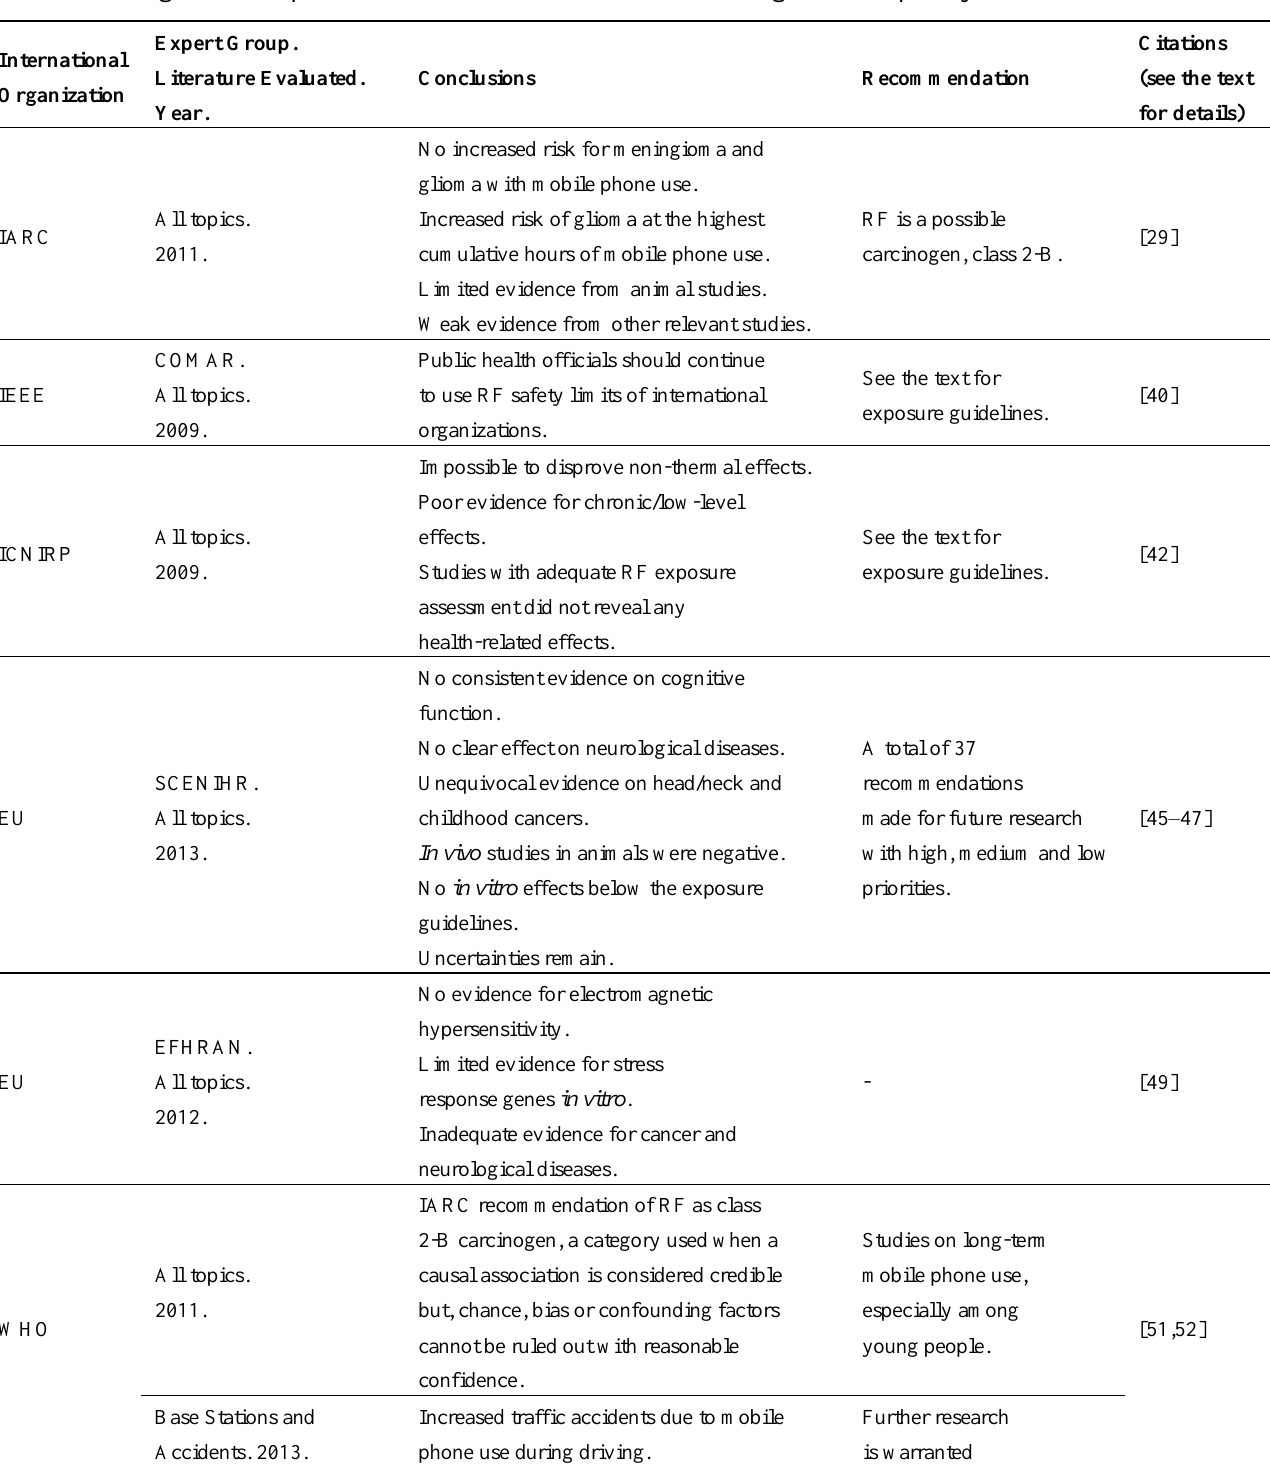
Table 1. Summary of international expert group evaluations on the biological and health effects reported in all animal and human cells (including human epidemiological investigations) exposed in vitro and in vivo to non-ionizing radiofrequency